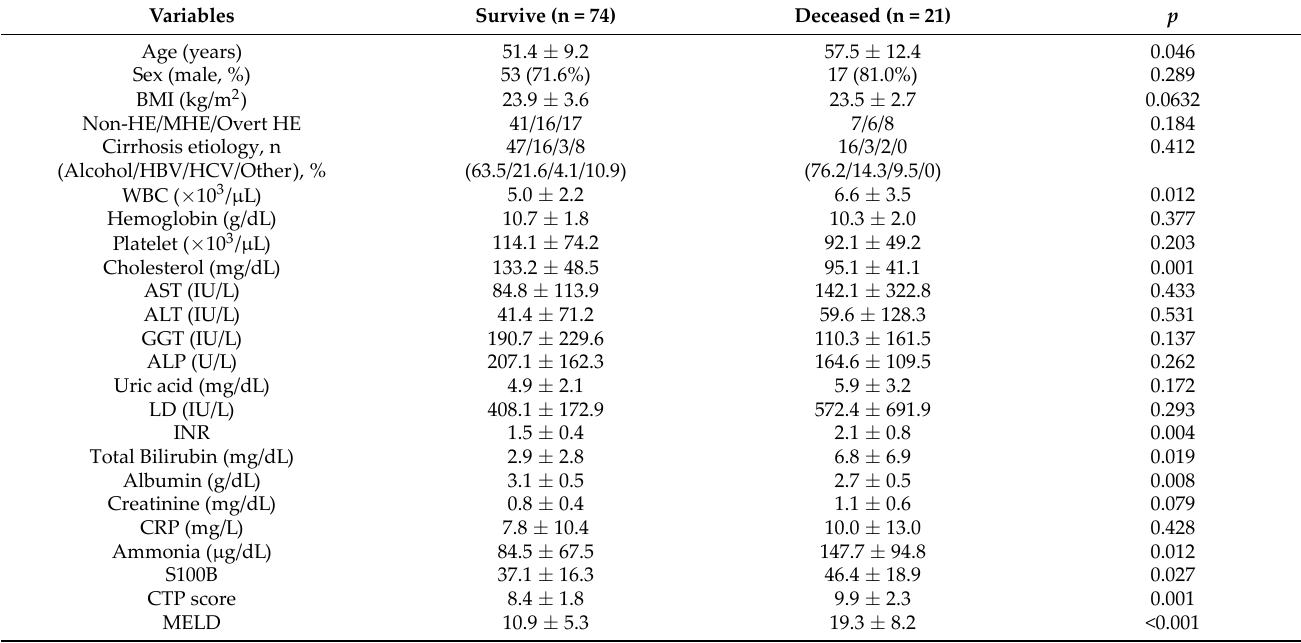
Table 6. Comparison of clinical characteristics of surviving and non‑surviving patients at 1‑year.